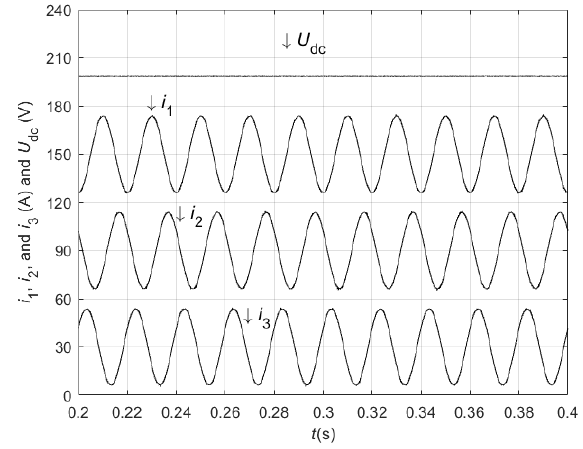
Figure 6. Simulation results of DC voltage and AC currents. AC currents, i 1 , i 2 , and i 3 , are amplified by a factor of 3 and displaced by 150, 90, and 30, respectively.